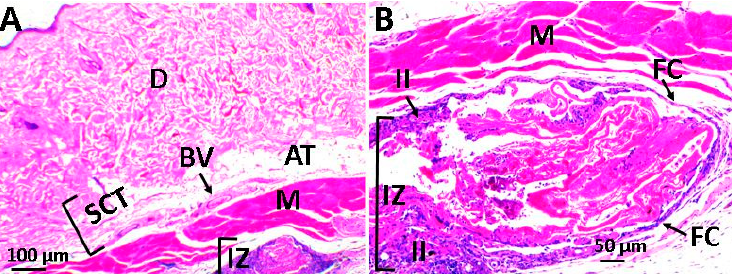
Figure 7. Image of the control sample using the hematoxylin and eosin technique. Image ( A ) at 4× and image ( B ) at 10×. E: epidermis, D: dermis, AT: adipose tissue, BV: blood vessel, SCT: subcutaneous cellular tissue, and M: muscle.